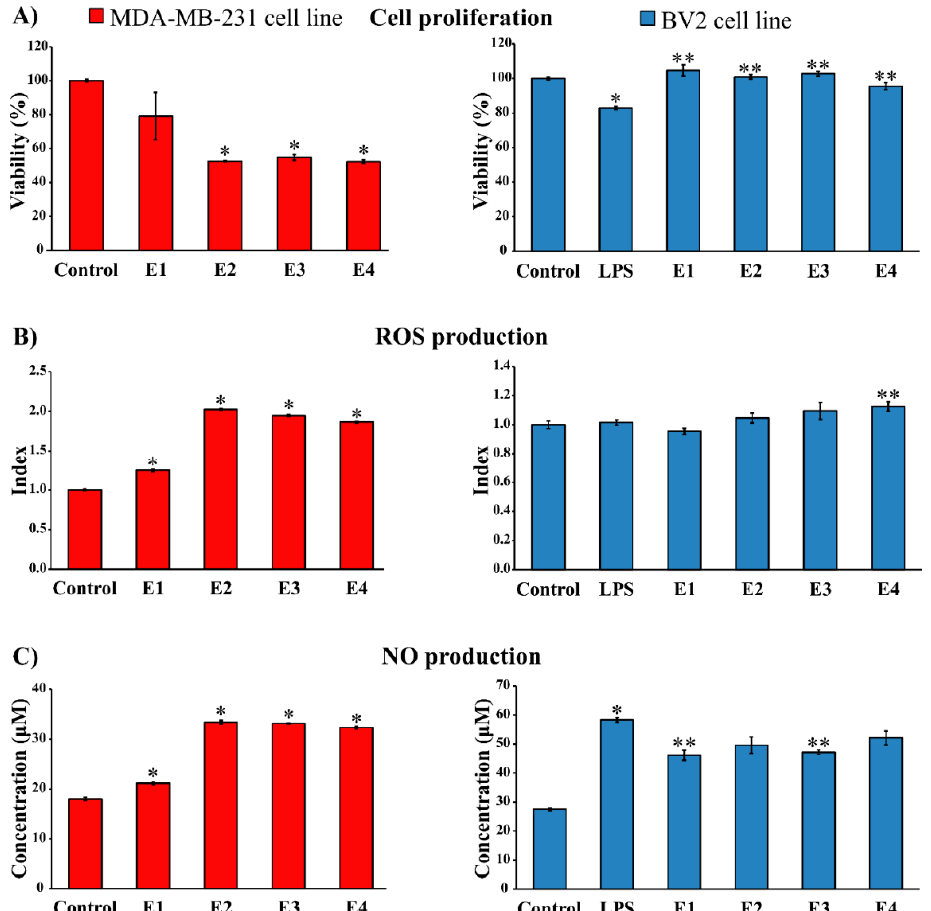
Figure 3. Immunomodulatory potential of Hypnum cupressiforme extracts (final concentration 10 µ g / mL) on ( A ) cell proliferation, ( B ) ROS production, and ( C ) NO production. The results are expressed as mean ± standard error of a representative experiment performed in quadruplicate. (* p < 0.05 di ff erent moss extracts and LPS-stimulated control cells vs. non-stimulated control cells; ** p < 0.05 di ff erent moss extracts vs. only LPS-stimulated control